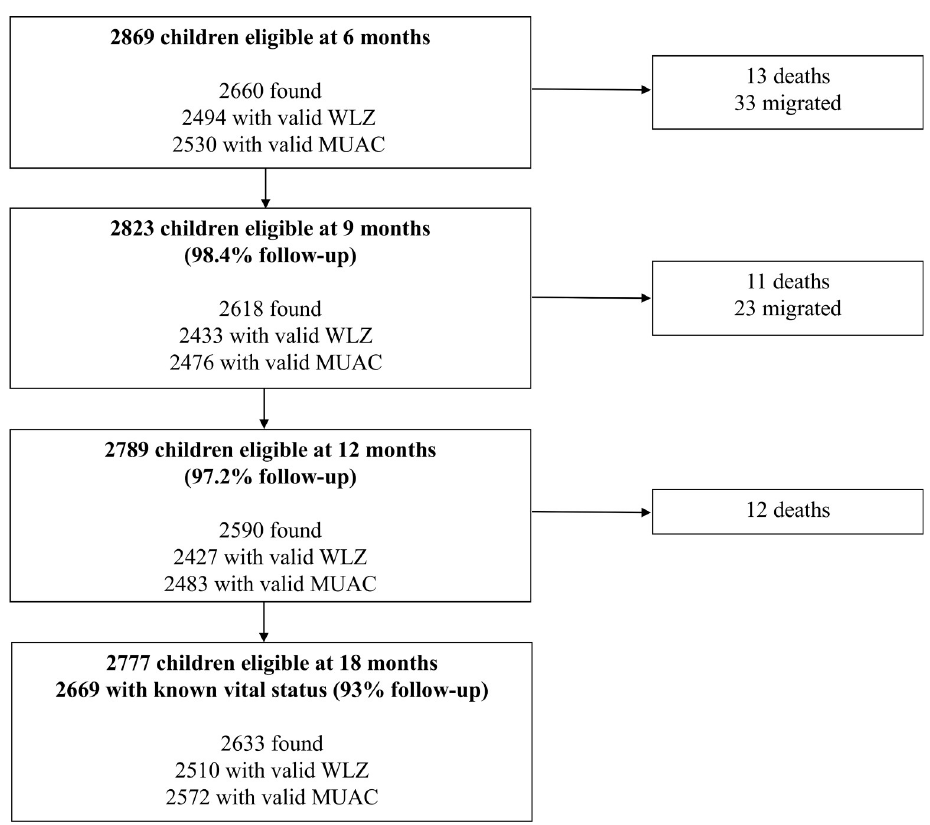
Fig 1. Flowchart describing the retention of children in the study. MUAC, mid-upper arm circumference; WLZ, weight-for-length z score.